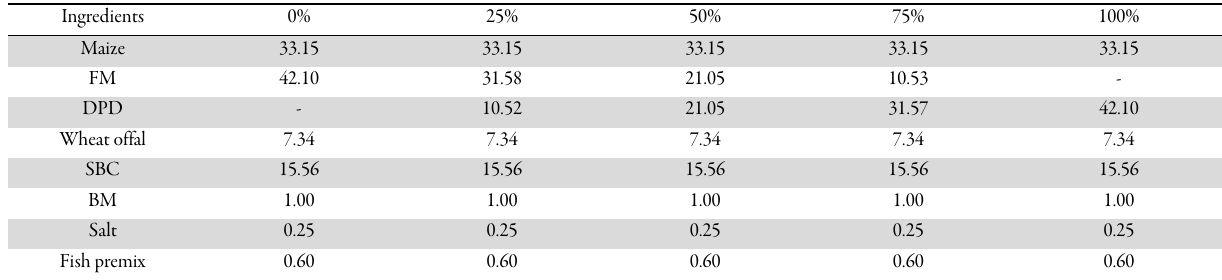
Table 1. Formulated diet substituted with dried poultry droppings